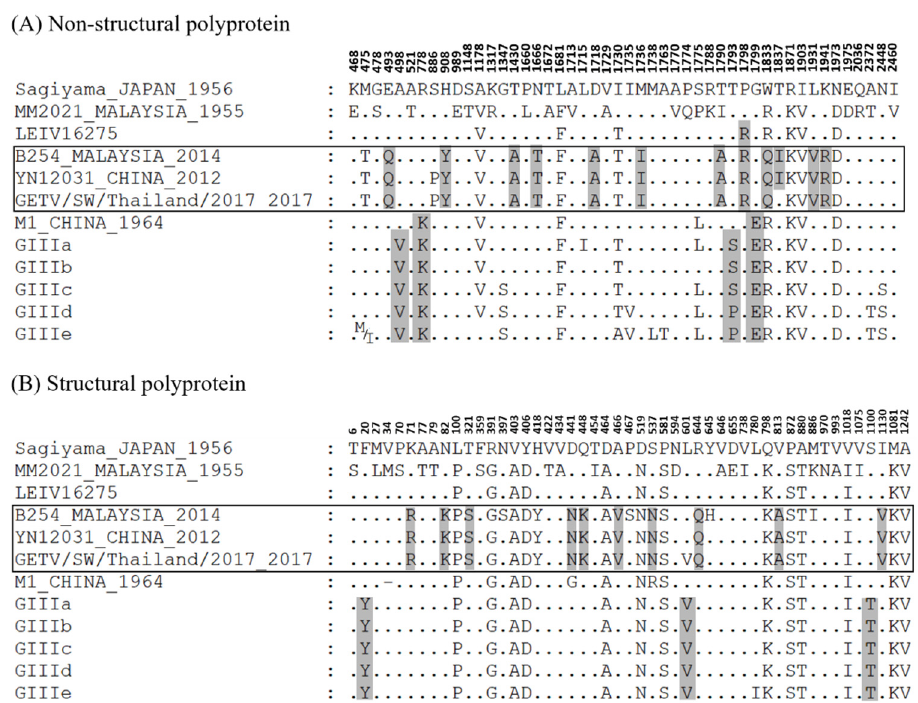
Figure 1. Comparison of ( A ) non-structural and ( B ) structural polyprotein amino acids between different groups of GETV. The dots represent similar amino acids in comparison to the GII GETV Sagiyama virus. The shaded areas represent the amino acid substitutions exclusive to the GETV GIII and GIV (in the box). The GETV GIII with homologous sequences are clustered together and indicated as GIIIa, GIIIb, GIIIc, GIIId, and